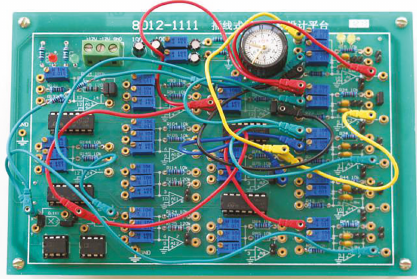
Figure 13: Experimental circuit board